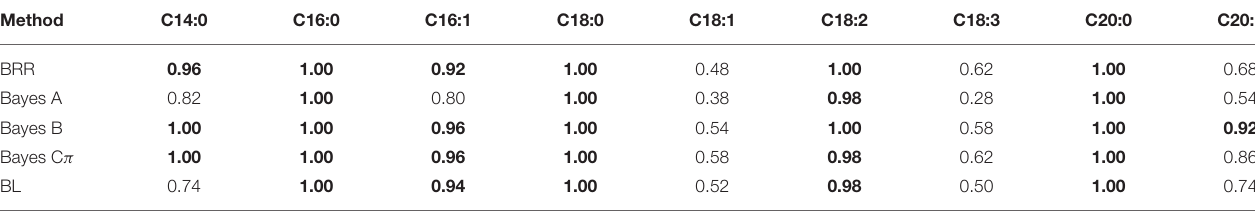
TABLE 1 | Proportion of resampling runs where BLUP using trait-specific genomic relationship matrices (TGRM-BLUP) outperformed genomic BLUP (gBLUP).